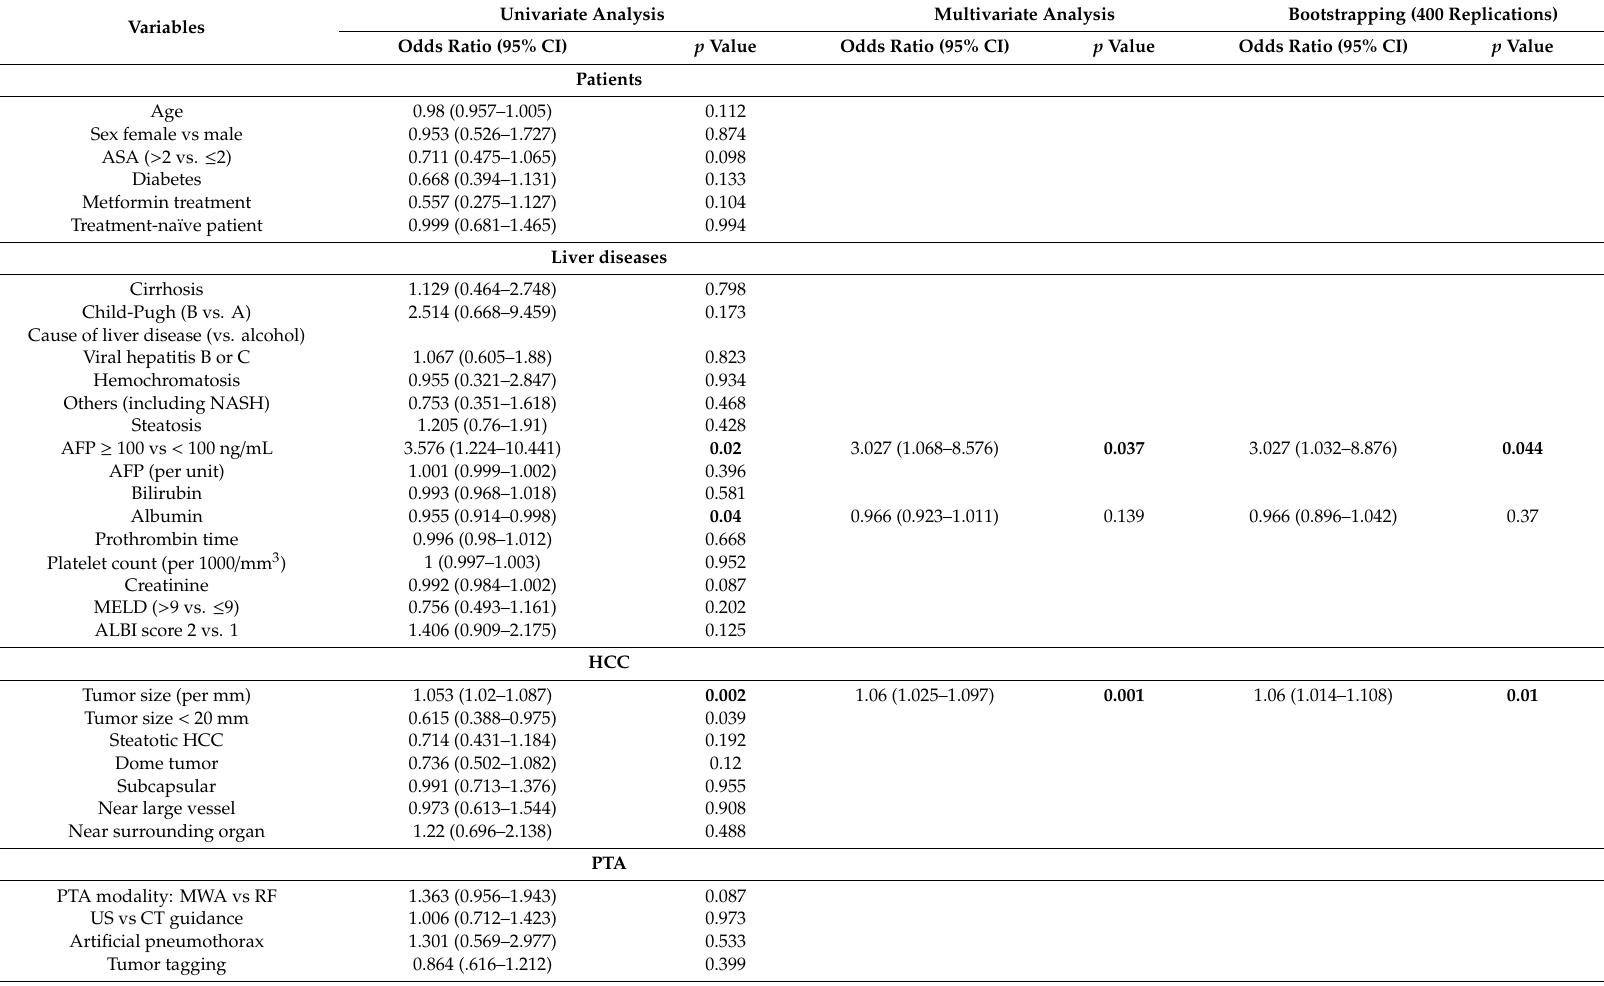
Table 3. Logistic regression analysis (GEE model) to predict intrahepatic distant tumor progression (per-tumor analysis).